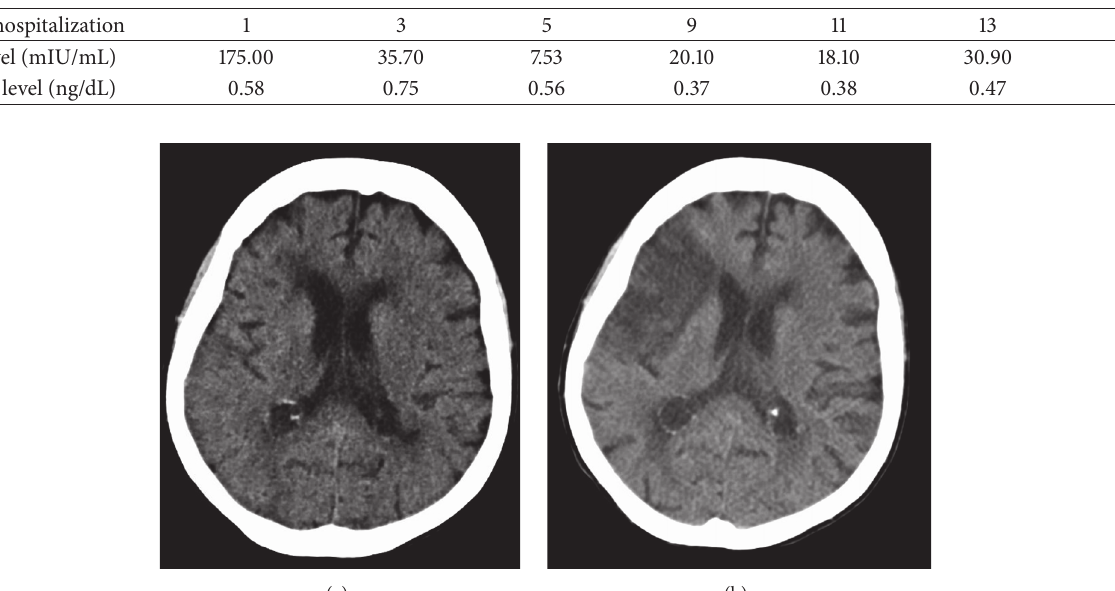
Figure 2: CT scan of the head performed on admission (a) compared to one performed after 14 days in the ICU (b) shows development of a large right MCA